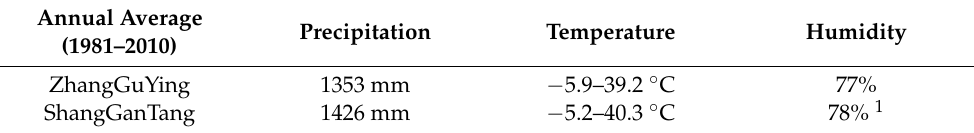
Table 1. Meteorological data of the two